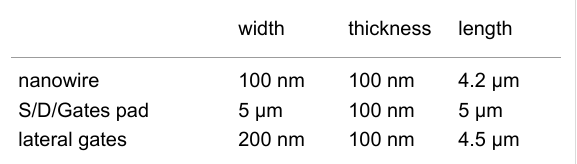
Table 1: Fabricated/simulated device